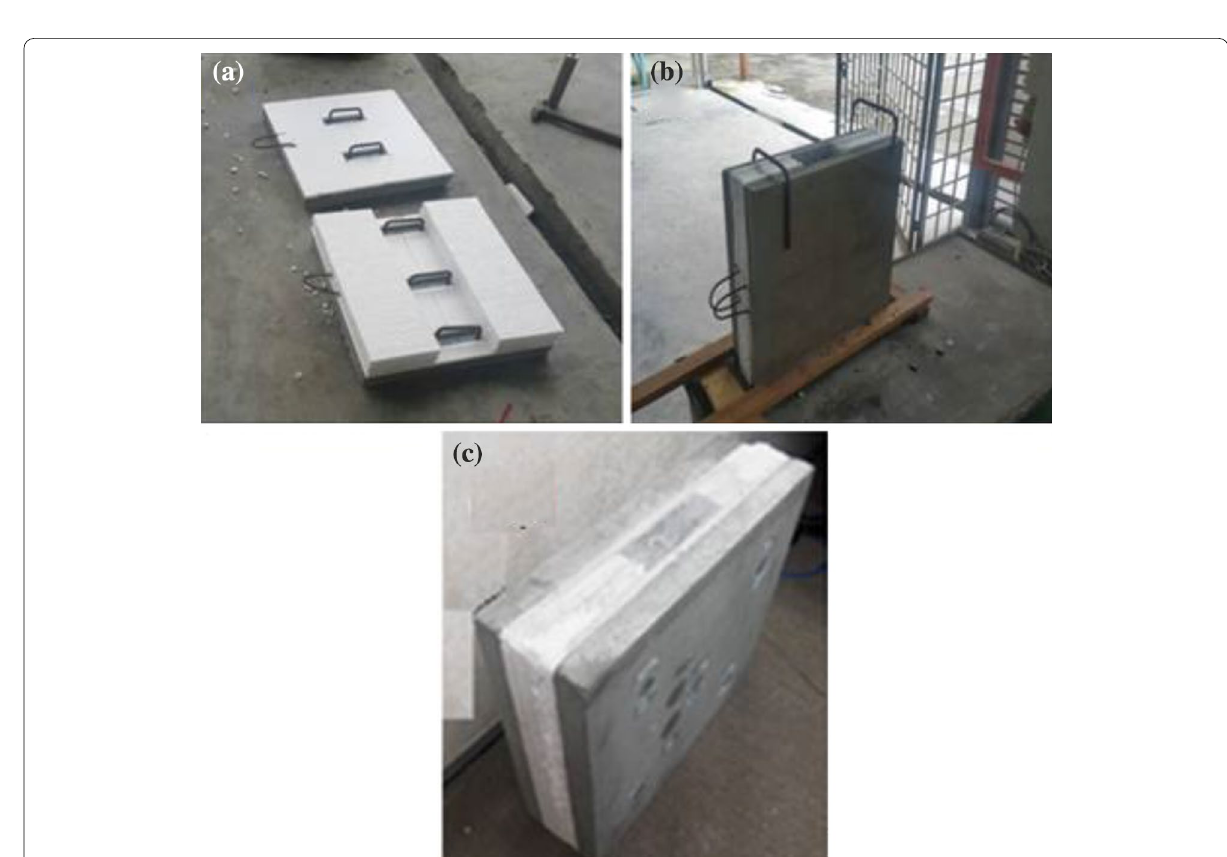
Fig. 3 Construction process: a insulation, b assembling and c completed panel.